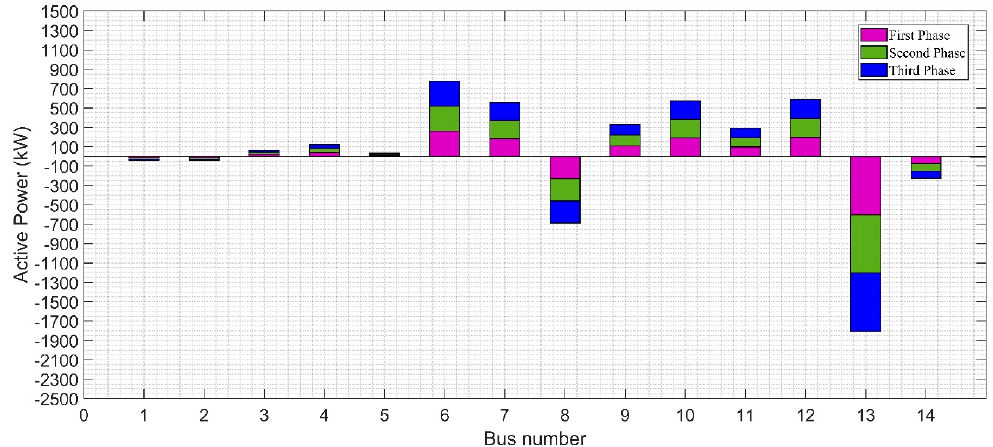
Figure 12. The maximum demand for power balance.